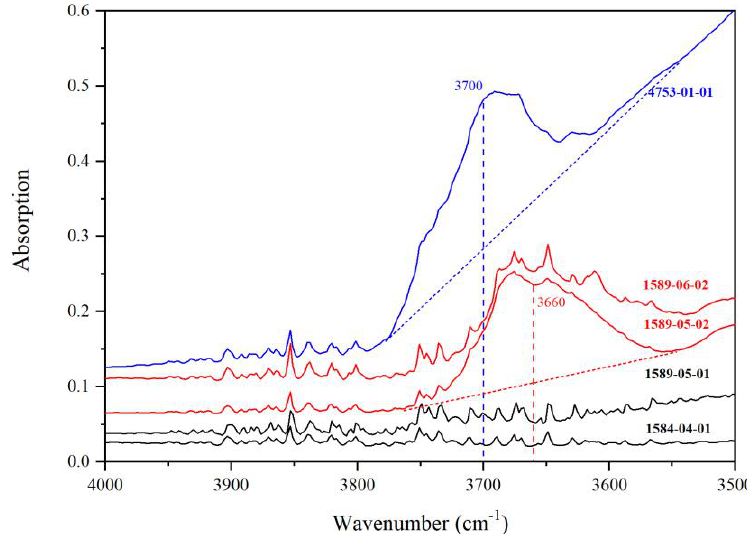
Figure 14. Effects on the broad water peak at ~3700 – 3660 cm −1 of the quench processes at high P and at 1 atm. For the low-H 2 O and intermediate-H 2 O Mg-Rw (Run 1584 and Run 1589, respectively), the quench process at high P did not lead to the formation of a peak at ~3700 cm −1 (black curves). However, for the high-H 2 O Mg-Rw (Run 4753), it resulted in an apparent water peak with a roughly-weighted mean wavenumber of ~3700 cm −1 (blue curve). The quench process at 1 atm may lead to a good preservation of the high- T IR signals formed by the new equilibrium at the annealing T and 1 atm, as exampled by the broad water peak with a roughly-weighted mean wavenumber of ~3660 cm −1 (red curves).